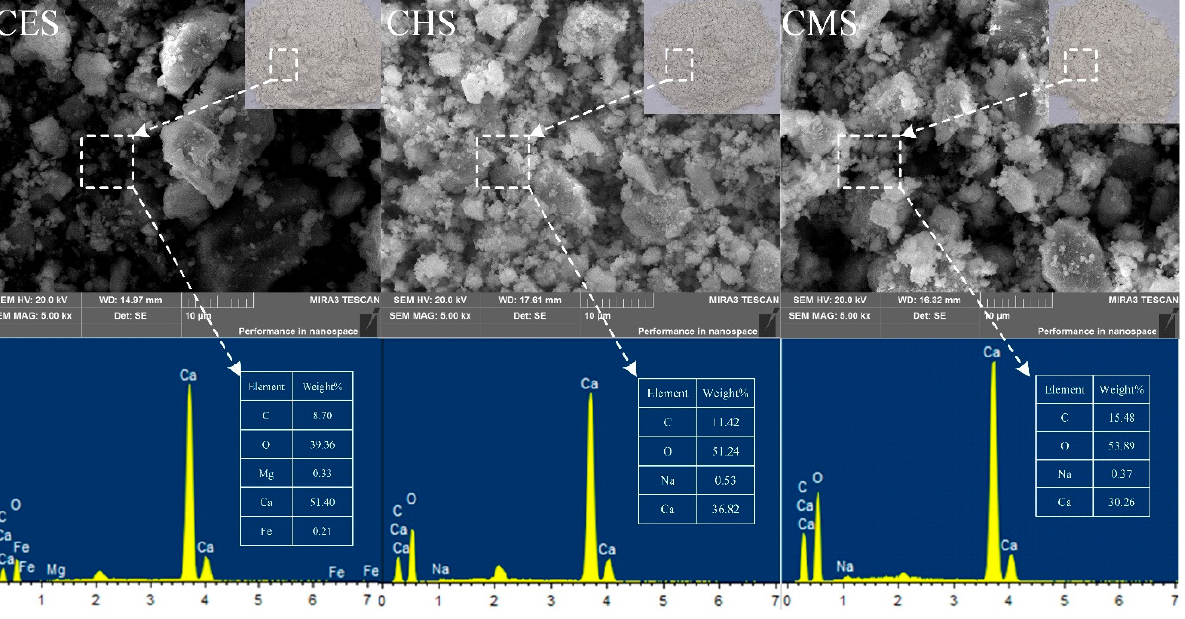
Figure 3. SEM images and EDS maps of shell bio-fillers.